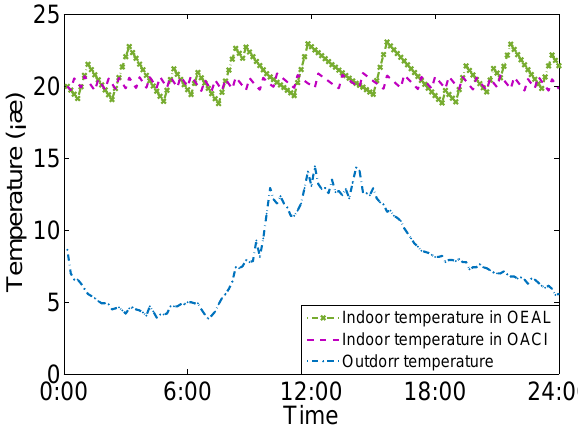
Figure 8. Comparison of the operation time for HVAC.